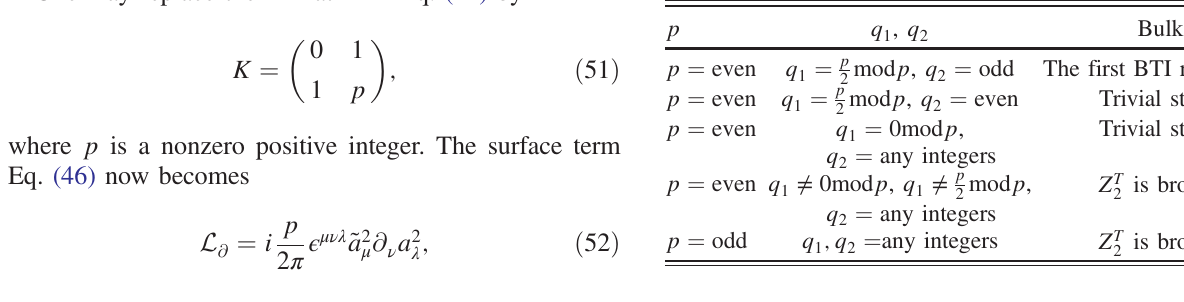
TABLE II. The surface of the first BTI root states (shown in